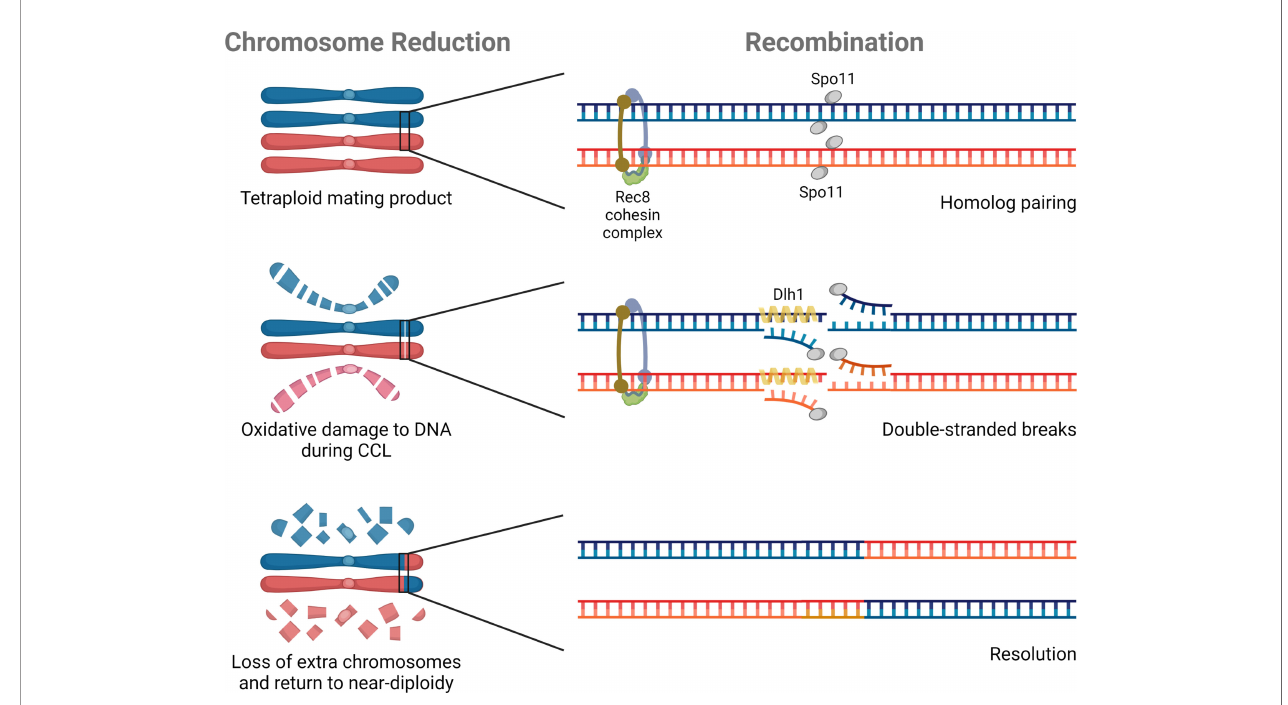
FIGURE 3 | Molecular components of parasexual reproduction. Three genes have experimentally de fi ned roles in C. albicans parasexual processes. SPO11 and REC8 contribute to ploidy reduction (depicted on the left), and all three genes ( SPO11 , REC8 , and DLH1 ) are involved in recombination during parasex (shown on the